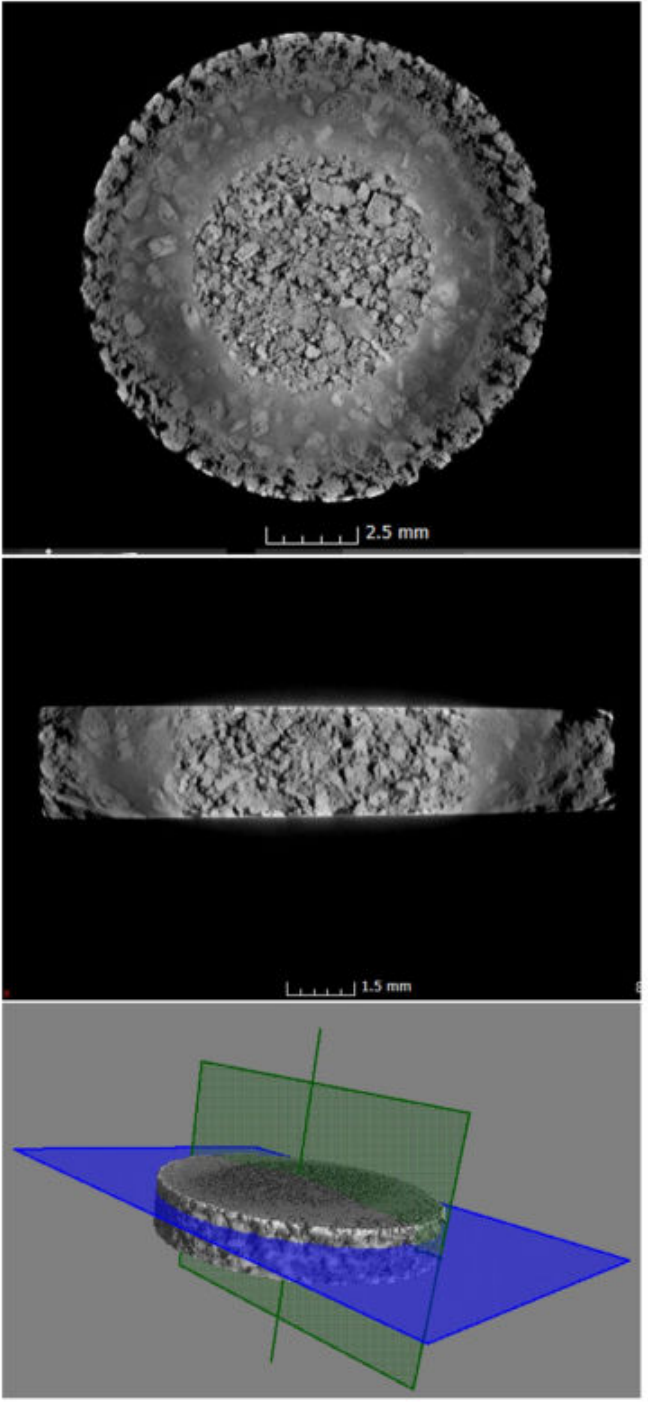
Figure 4. Microtomography observations of the Zr-Ti/Zr-Ti sample. Cross-section of the specimen (top photo), section along the specimen (middle photo) and in the last photo the location where the above images were